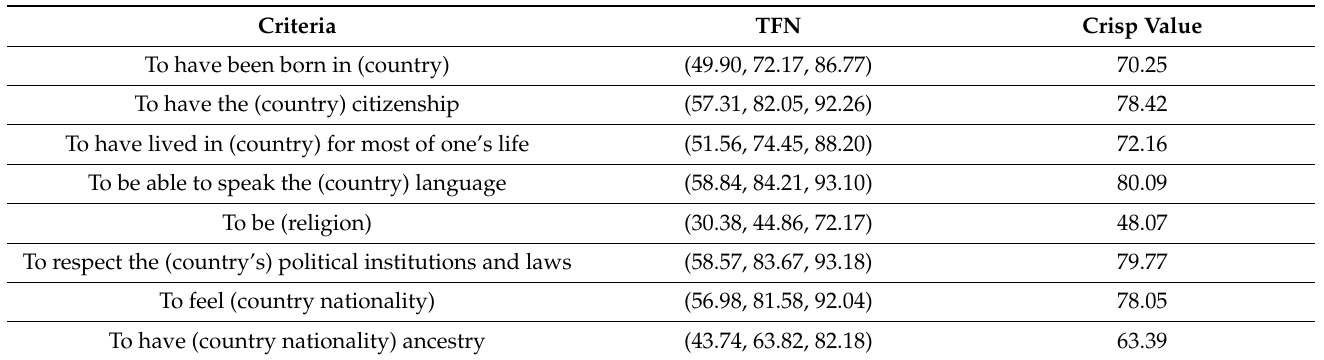
Table 2. Triangular Fuzzy Numbers (TFNs) and crisp clarified values for the total sample.